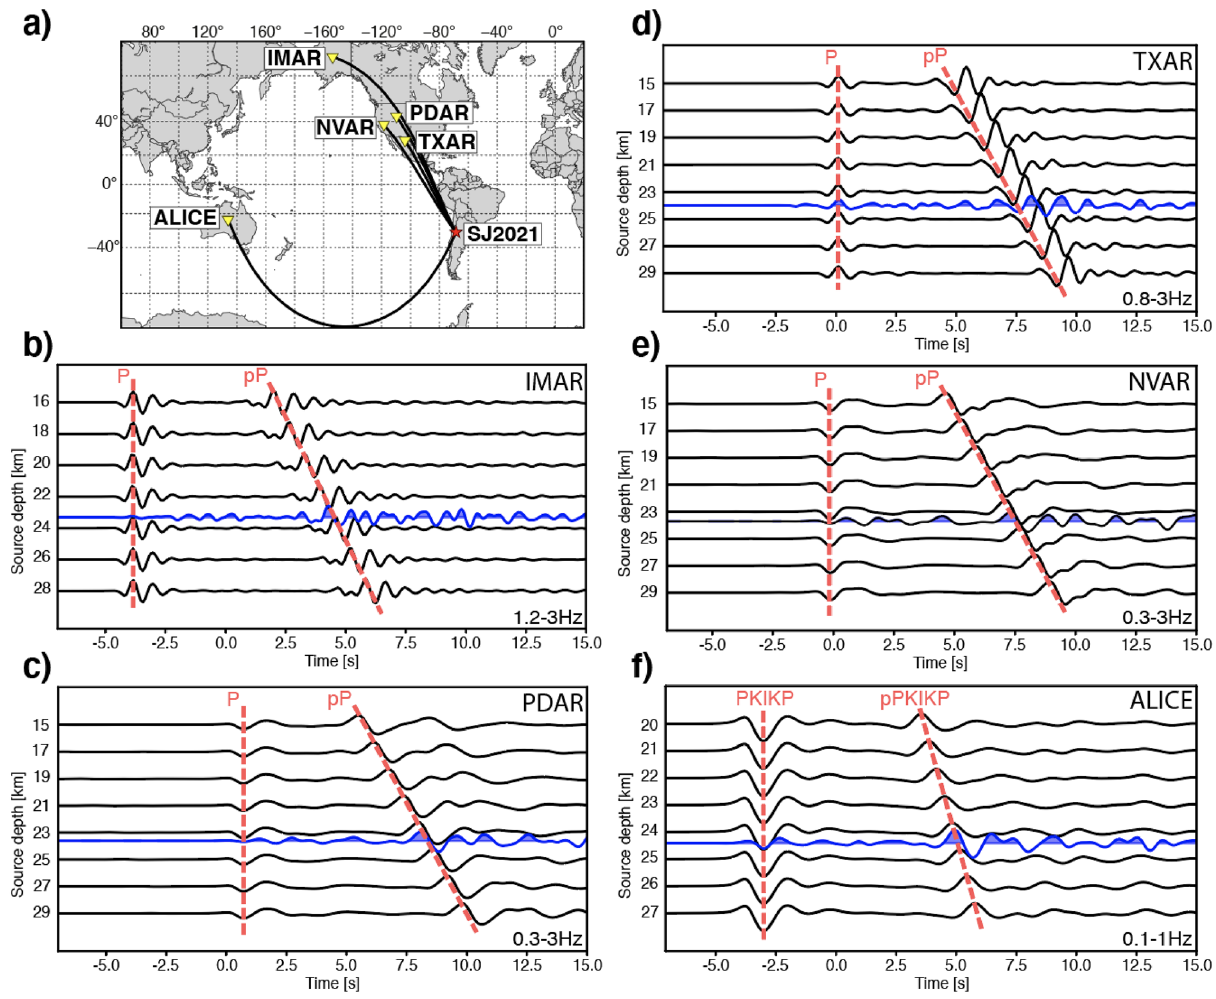
Figure 3. Plots comparing the synthetic (black) waveforms simulating different focal depths of the San Juan 2021 earthquake (SJ2021) and beamformed array recordings of the SJ2021 event (blue). The best fit between synthetic and observed waveforms is achieved for focal depths between 23 and 25 km. Red dashed lines denote direct P arrivals and corresponding depth phases. This figure was generated using the Python Matplotlib libraries (V3.5.2, https:// matpl otlib. org/). ( a ) was created using the GMT package (V.6.0.0, https:// www. gener ic- mappi ng- tools.